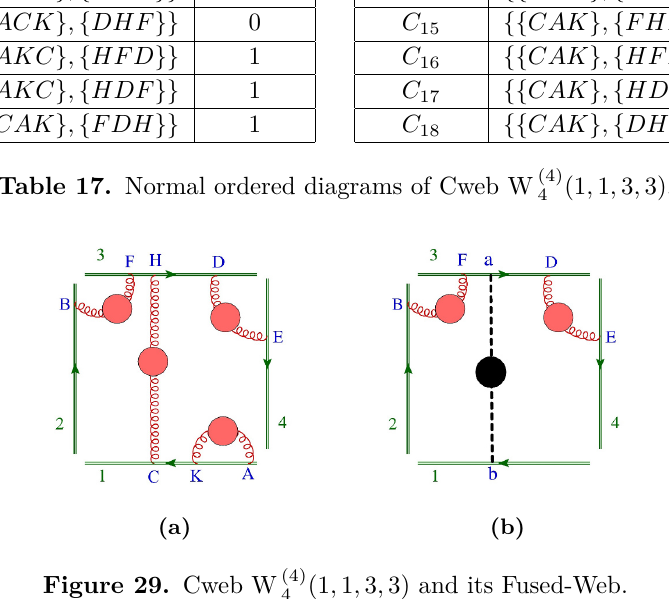
Figure 29. Cweb W (4)